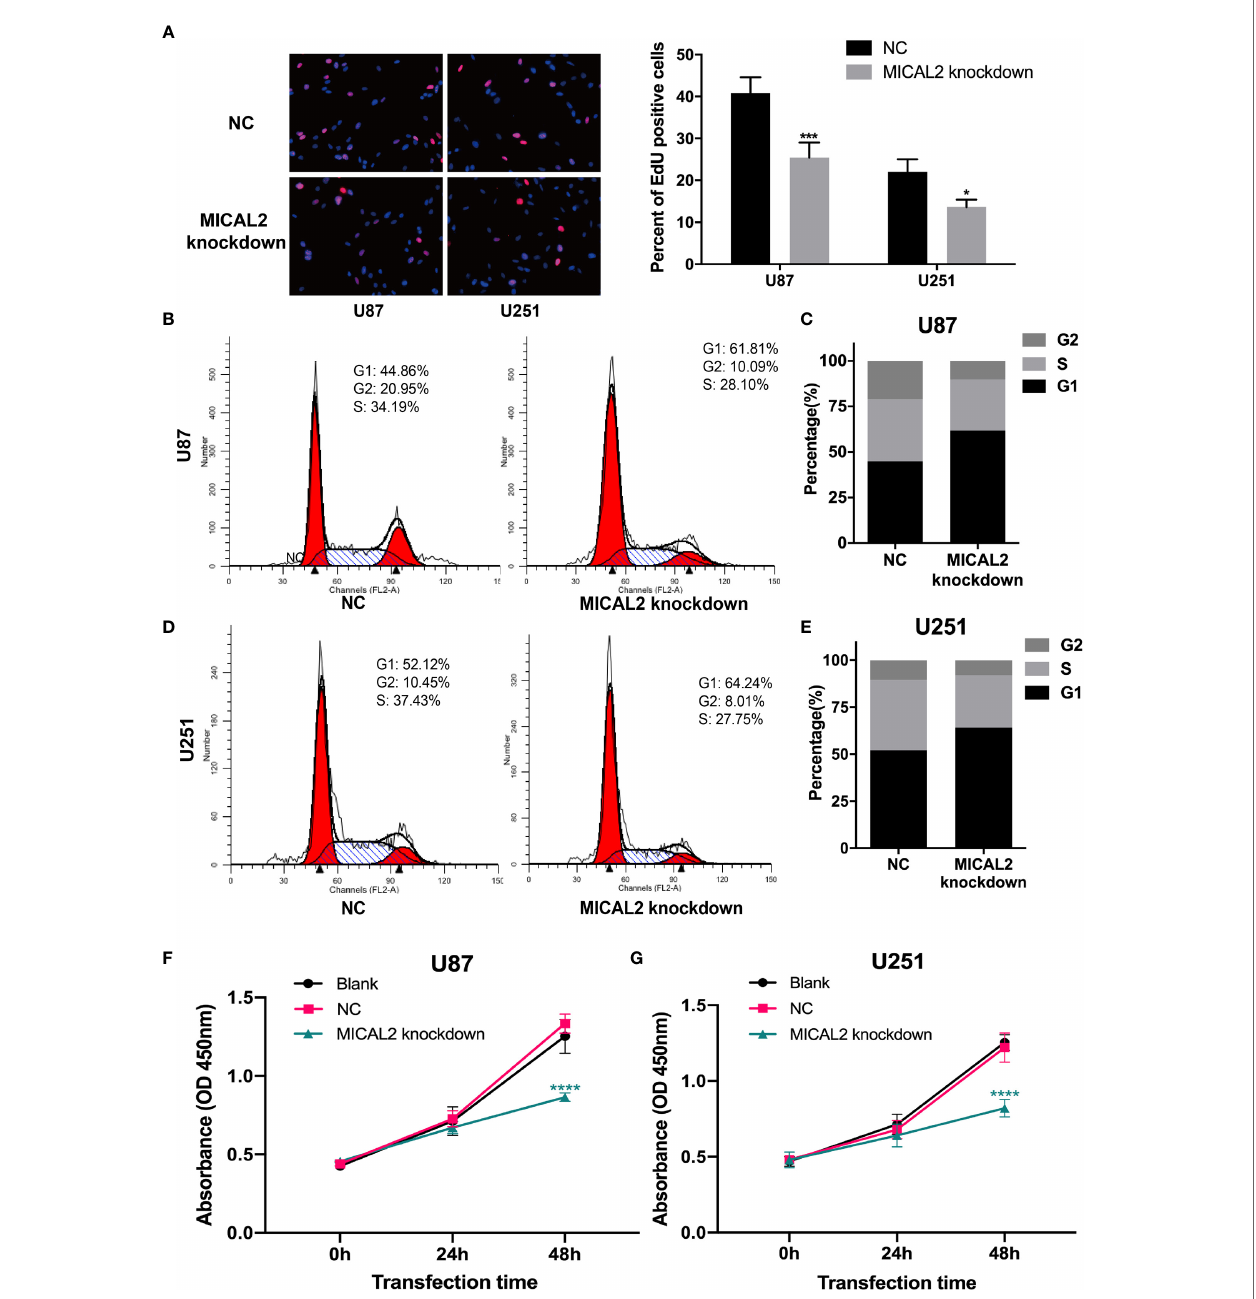
FIGURE 2 | MICAL2 promotes proliferation of glioma cells in vitro . (A) EdU incorporation assay was used to detect U87 and U251 cell proliferation. There was a signi fi cant decrease of EdU-positive cells in U87 ( p < 0.001) and U251 ( p < 0.05) MICAL2 knockdown cells. (B – E) Cell cycle of U87 and U251 cells were analyzed via fl ow cytometry. Analysis of the cell cycle of U87 and U251 MICAL2 knockdown cells revealed a decrease in the proportion of cells in G2 and S phases. (F, G) CCK-8 assay demonstrated that inhibition of MICAL2 gene expression suppression had a signi fi cant inhibitory effect on glioma growth. Data are shown as the means ± SEM of three experiments. *p < 0.05, ***p < 0.001, ****p <